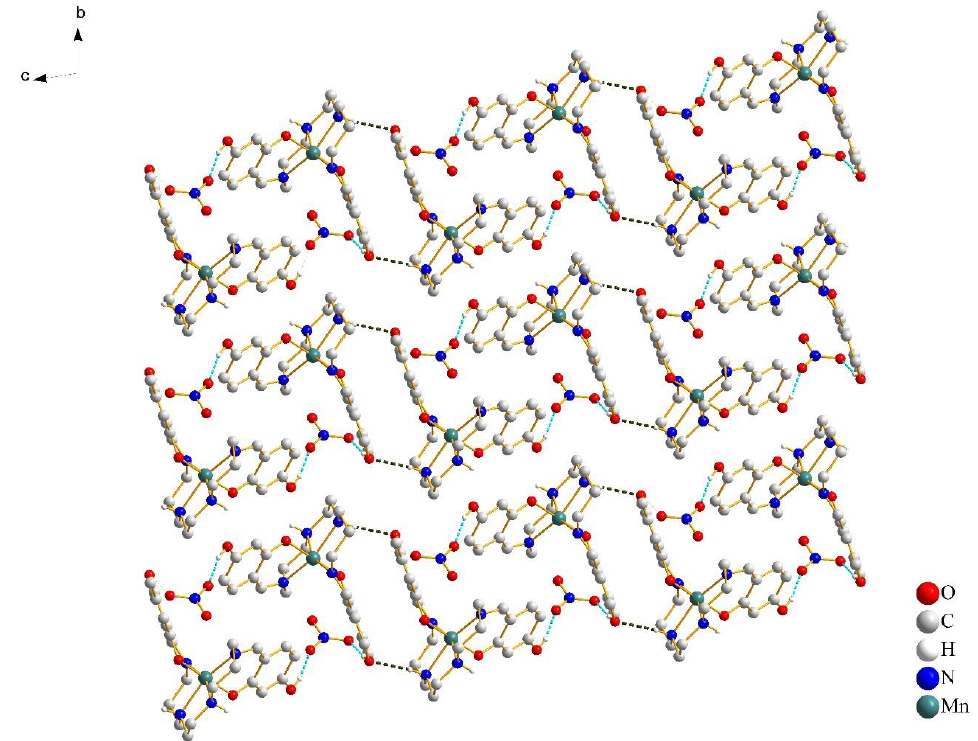
Figure 3. Crystal packing of complex 1 at 100 K, viewed along the a -axis. The cation – anion O – H···O hydrogen bonds are shown with cyan blue dash lines and the cation – cation N – H···O hydrogen bonds are shown with black lines. Most of the hydrogen atoms were omitted for clarity, except for those involved in hydrogen bonds.